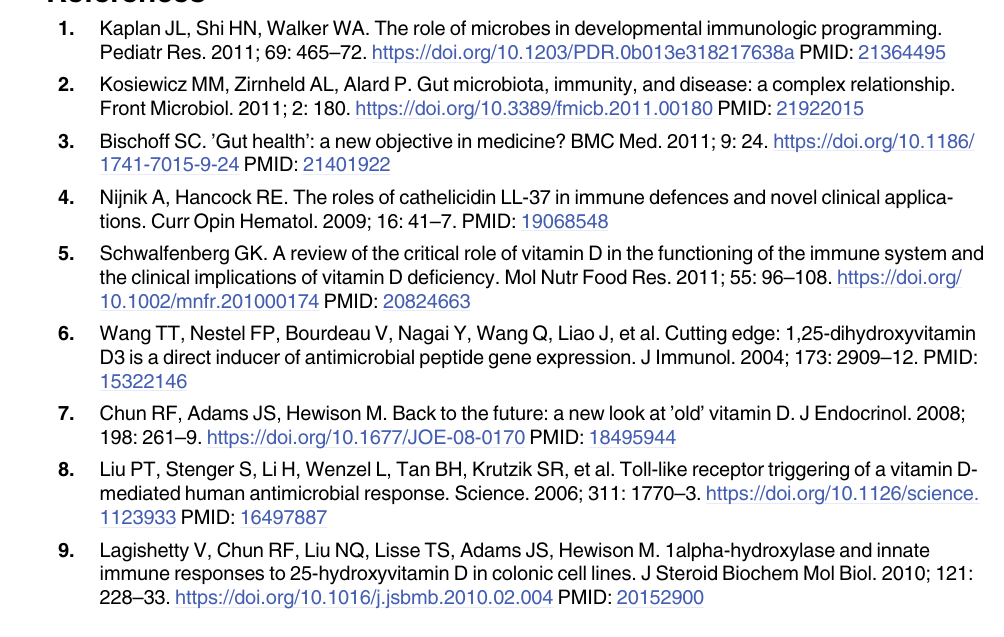
S3 Fig. Boxplots to describe log10 CFU of Bifidobacterium spp., Escherichia coli , Bacter- oides fragilis group, Clostridium difficile , and Lactobaccilus spp. in infants colonized with the respective bacteria in relation to vitamin D supplement use of breastfed